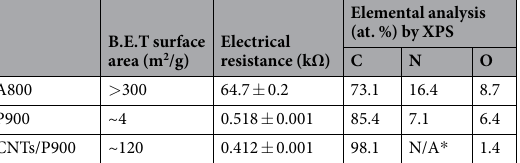
Table 1. Properties of different carbon foam samples. * Below the detection